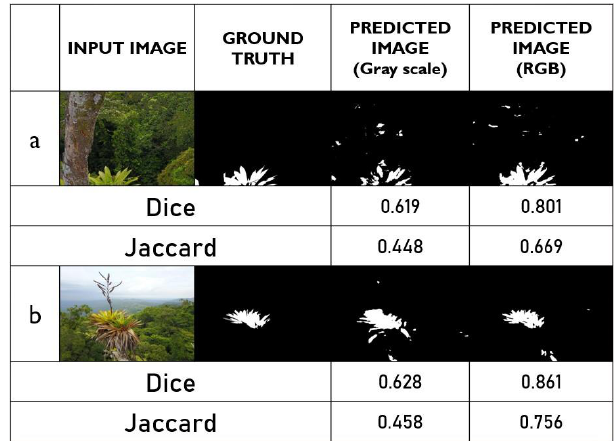
Figure 5: Images that have the target epiphyte under good illumination and high occupancy Figure 5 has the target with high occupancy and is accurately seg- mented. The tree’s bark was segmented greatly by the grayscale model whereas the bark was less segmented in the RGB model.